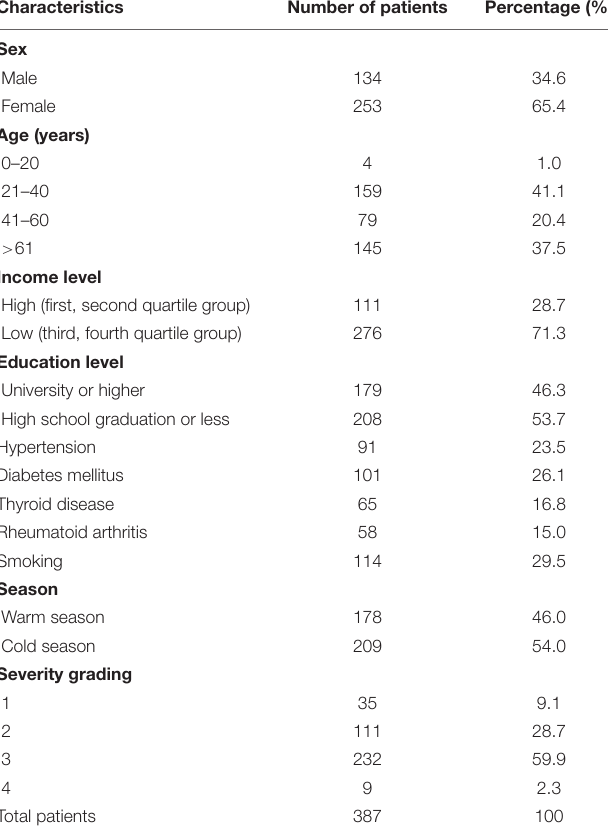
TABLE 1 | Demographic characteristics and seasonal distribution of dry eye disease